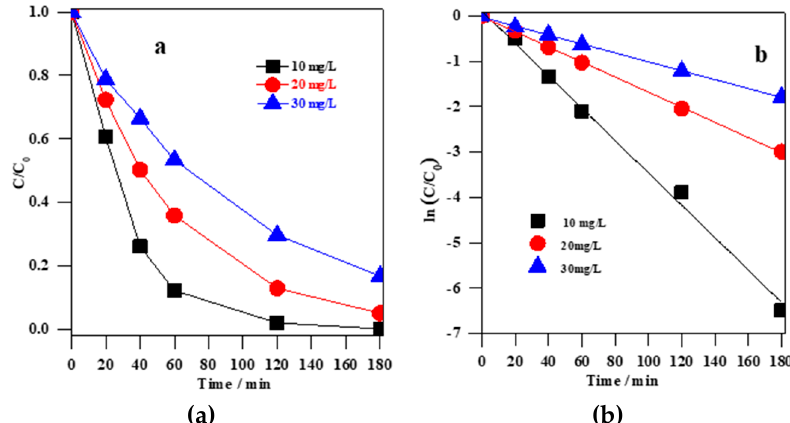
Figure 10. ( a ) Photodegradation of 10 mg L − 1 MC-LR in the presence of CDT-0.00 (0.4 g L − 1 )